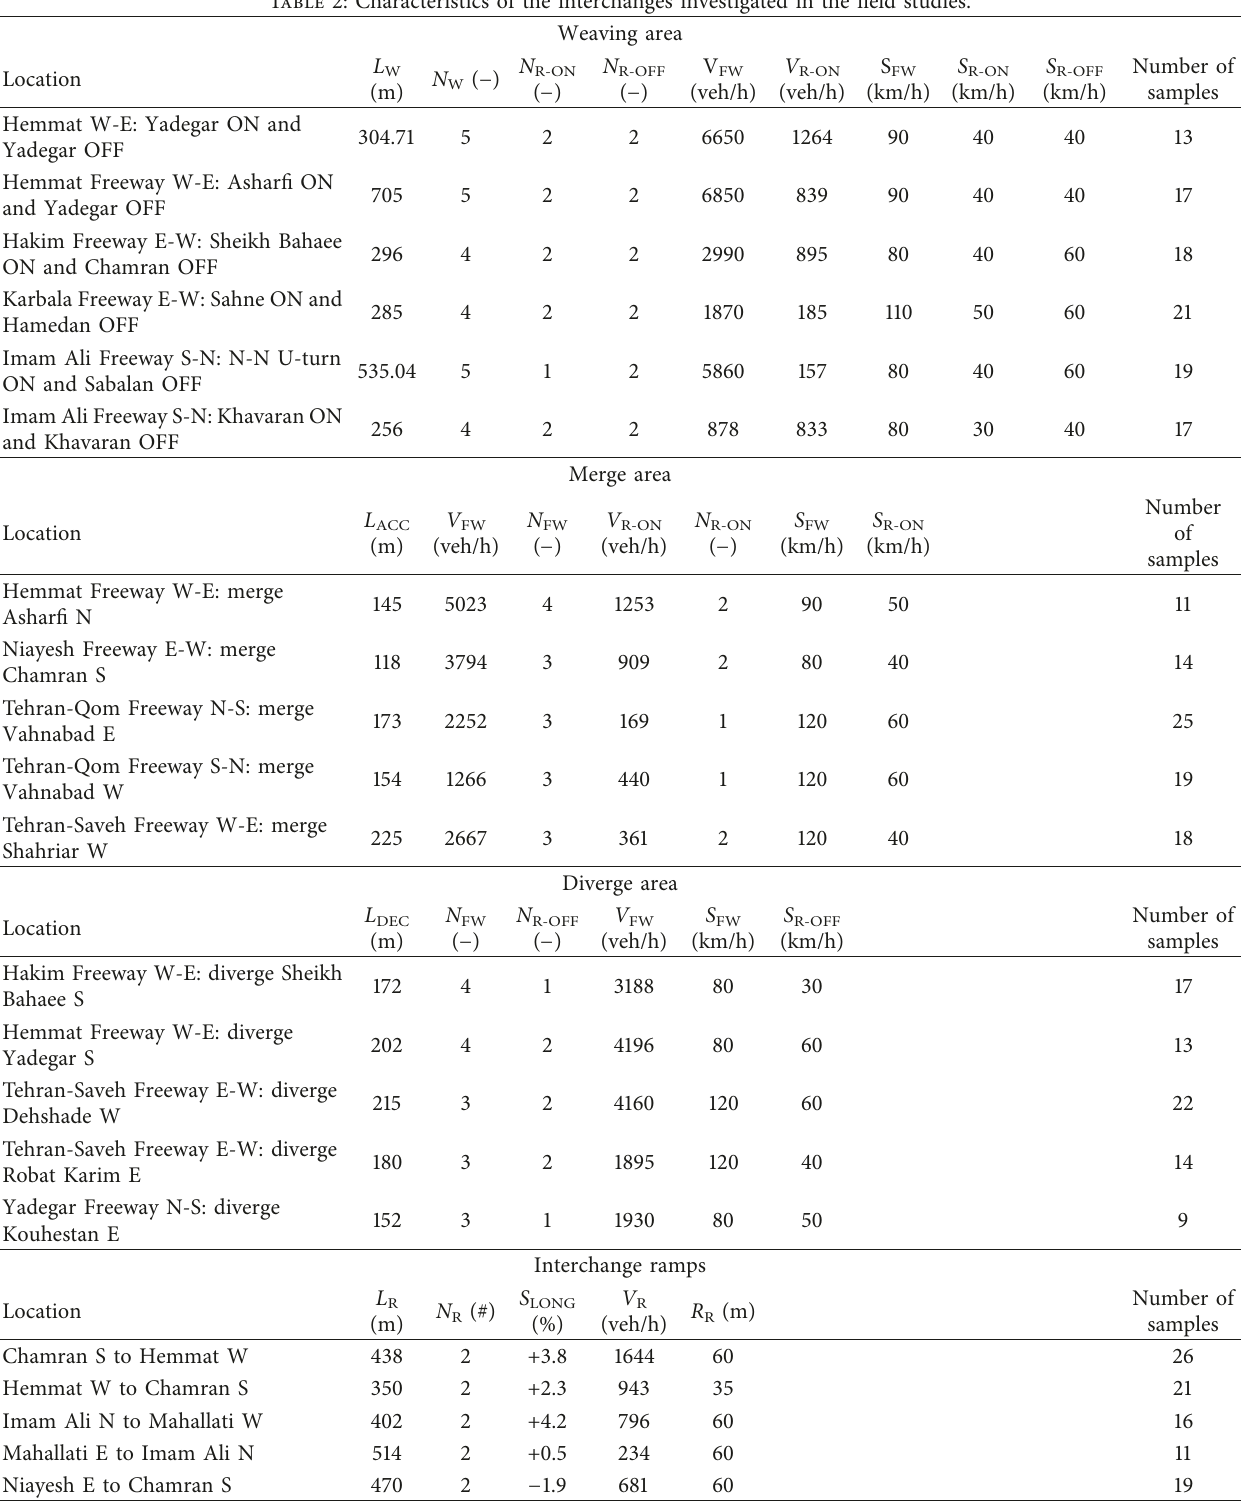
Table 2: Characteristics of the interchanges investigated in the field studies. Weaving